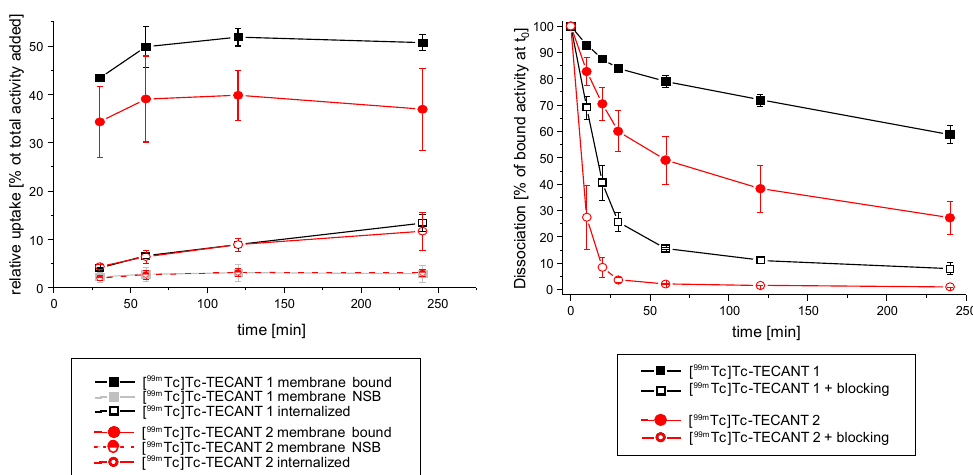
Figure 2. ( Left ): Cell-surface (membrane) specific bound, non-specific binding (membrane NSB) and internalization of [ 99m Tc]Tc-TECANT-1 and [ 99m Tc]Tc-TECANT-2 over time (data are shown as means ± SD for 3 independent experiments). ( Right ): Dissociation-assay of [ 99m Tc]Tc-TECANT-1 and [ 99m Tc]Tc-TECANT-2 (data are shown as means ± SD from 3 independent experiments).